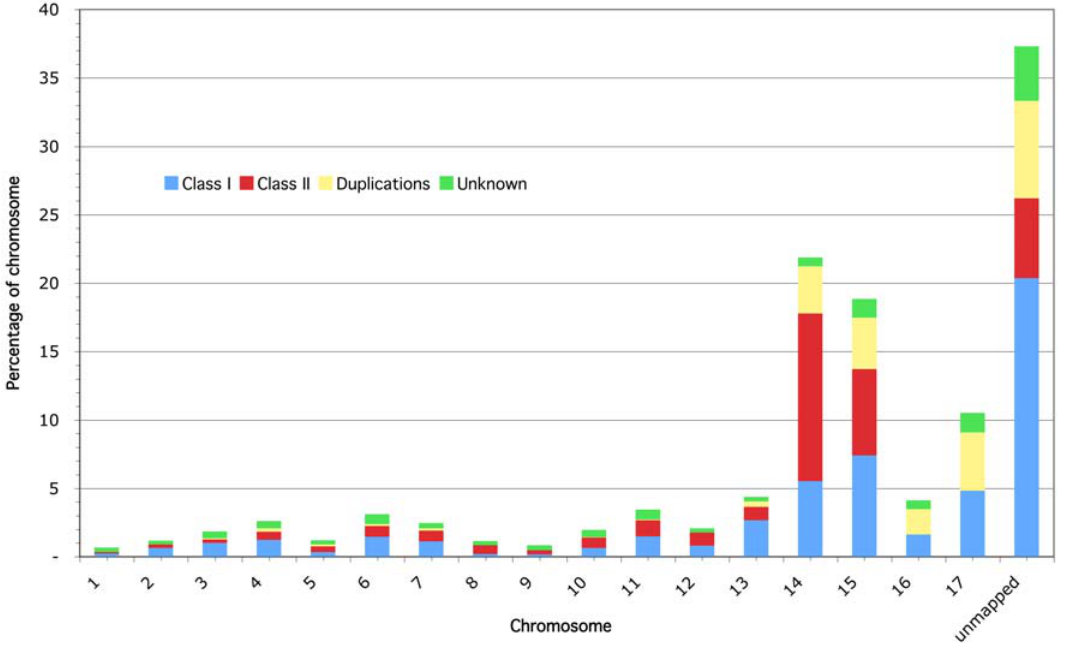
Figure 8. Distribution of repeat elements in the N.haematococca genome. The bar graphs show homologs of previously known or novel transposable elements (Class I, retrotransposons; Class II, DNA transposons; Duplications, repeated regions that are mutated duplicated genes, usually with TE fragments; unknown, repeats that do not match any known or hypothetical proteins). A t-test on the log odds ratio of repetitive and unique fractions of each chromosome revealed that chromosomes 14, 15, and 17 had a higher repetitive content than the other chromosomes